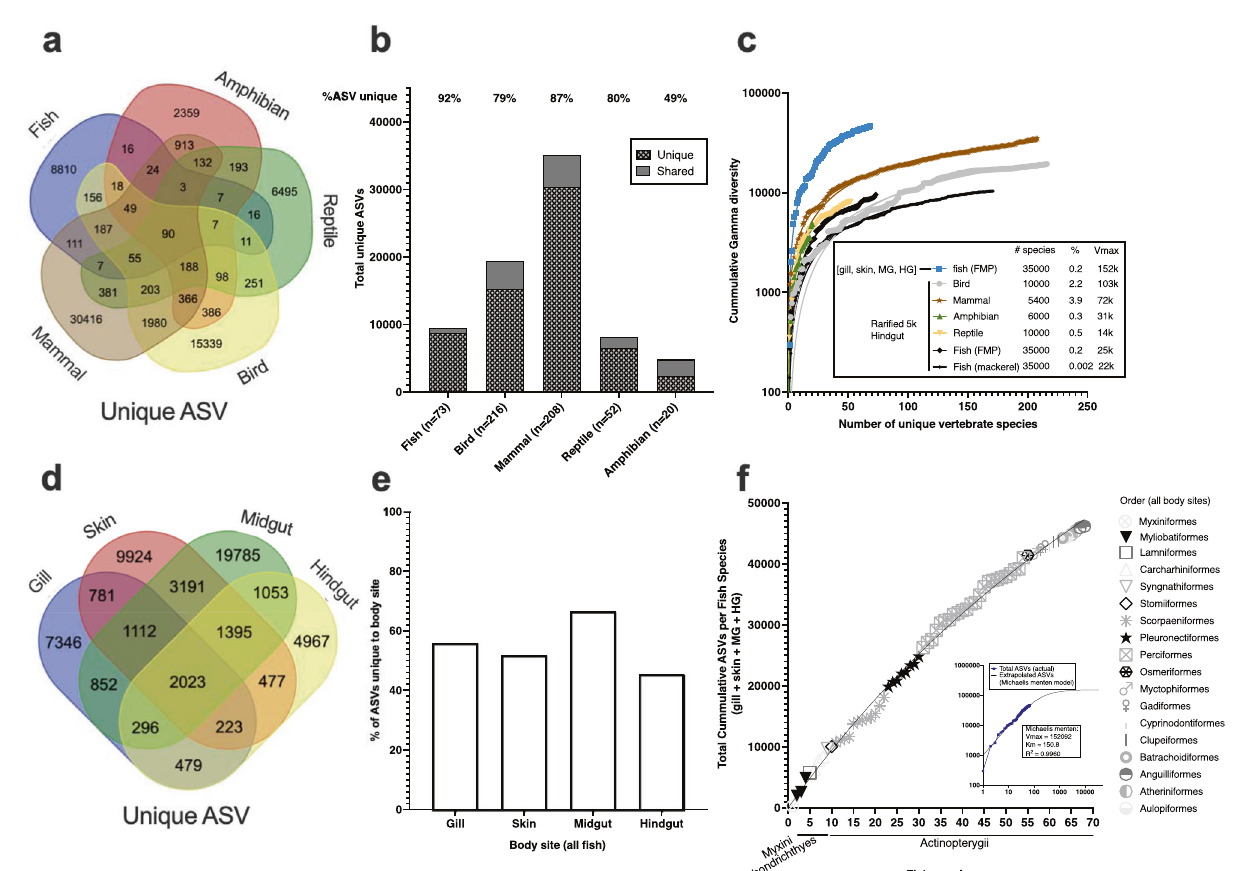
Fig. 8 | Total microbial diversity across vertebrate hindguts and within multi- plebodysitesof fi sh.a Hindgutmicrobiotasamplesfrom569speciesofvertebrates were rari fi ed to 5000 reads and unique or shared ASVs determined for each